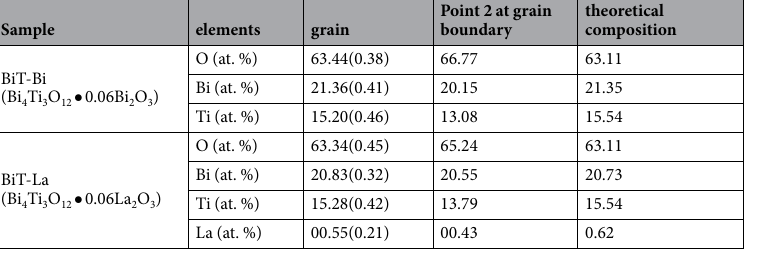
Table 2. Composition analyses for BiT-Bi and BiT-La. EDS data for grain composition were obtained by surface scans on five entire grains, and the mean value and standard deviation were listed. Point 2 at grain boundary was shown in Fig. 2a and b.